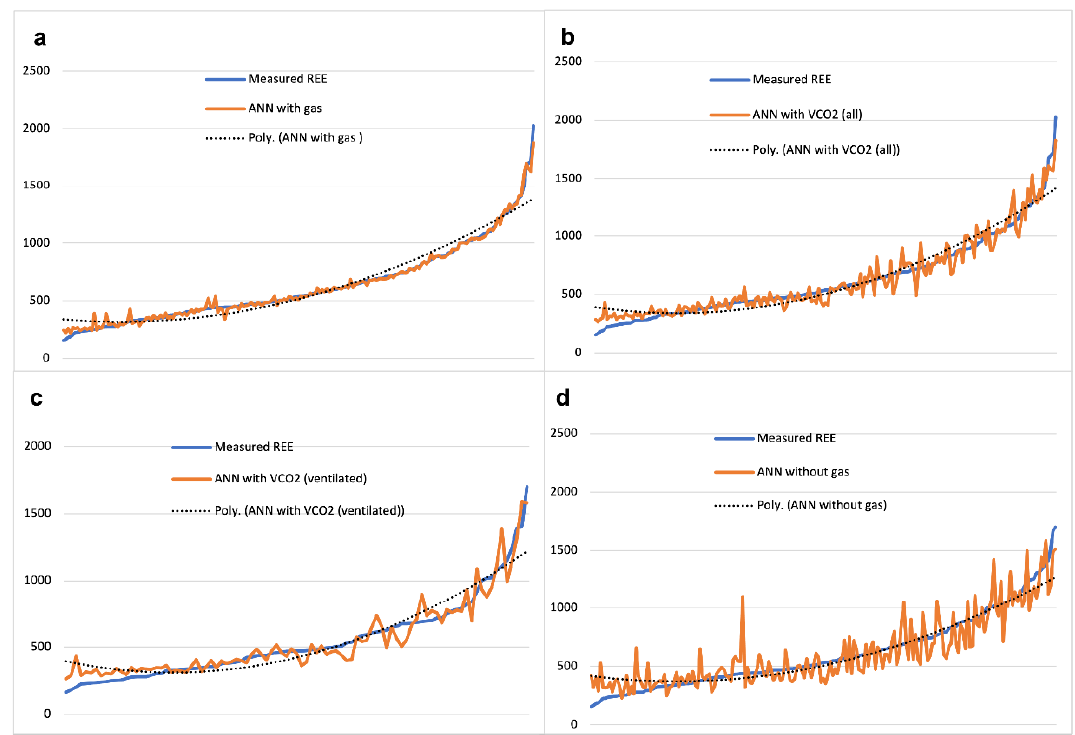
Figure 5. Data set 2 real REE approximation with ANN. Legend. ANN with gas ( a ), ANN with VCO 2 (all subjects) ( b ), ANN with VCO 2 (ventilated subjects) ( c ), ANN without gas ( d ). Abbreviations: REE = Resting Energy Expenditure; ANN = Artificial Neural Networks; VCO 2 = Carbone Dioxide Production.